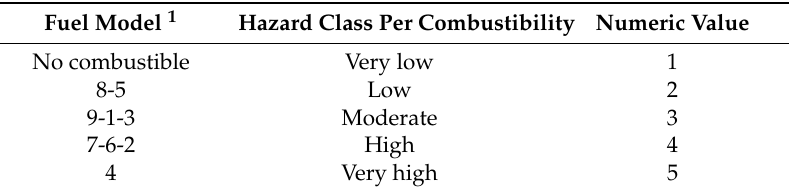
Table 2. Hazard classification of fuel models.